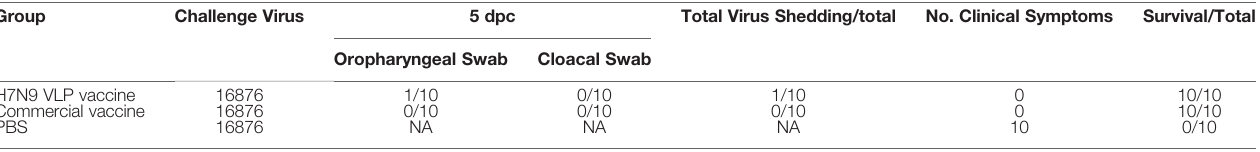
TABLE 3 | Virus shedding after a lethal-dose homologous in fl uenza virus challenge of chickens.